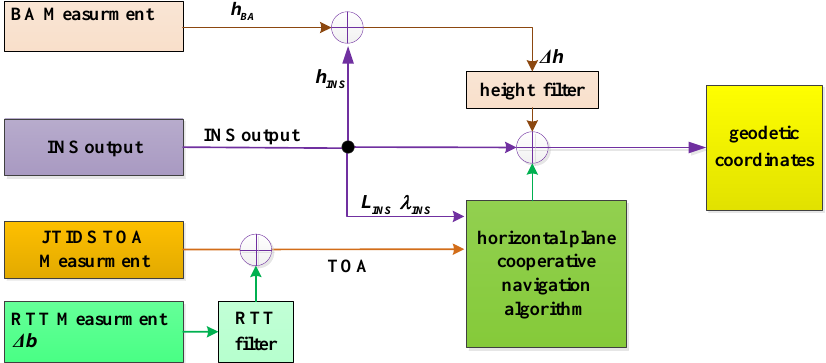
Figure 3. Cooperative navigation method.